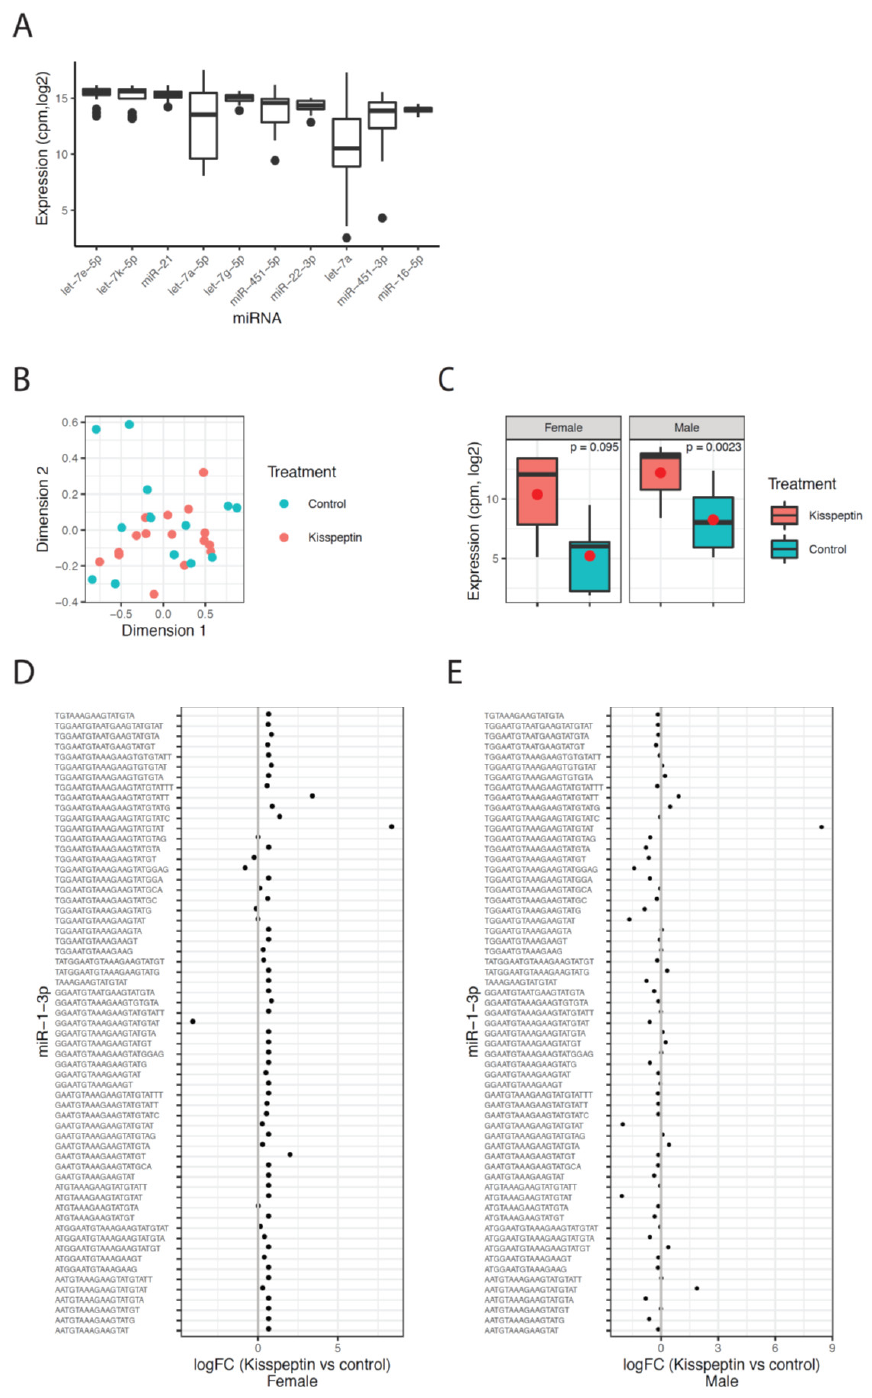
Figure 7. MicroRNA sequencing results. ( A ) Levels of the top 10 highest expressed miRNAs shown as the normalized expression (cpm, log2) for each miRNA across all samples. ( B ) Multidimensional scaling plot (MDS) of the miRNA expression data colored by treatment, red color for animals treated with kisspeptin and blue color for untreated fish. ( C ) Expression of miR-1-3p in kisspeptin and control treatments for female and male samples, respectively. The mean of each group is shown as a red circle. The p -values are the Benjamini–Hochberg adjusted p -values as calculated by limma in R. ( D ) Fold change values (log2) for all detected isomiRs of miR-1-3p between kisspeptin and control treatment in females. ( E ) Similar as in D for male